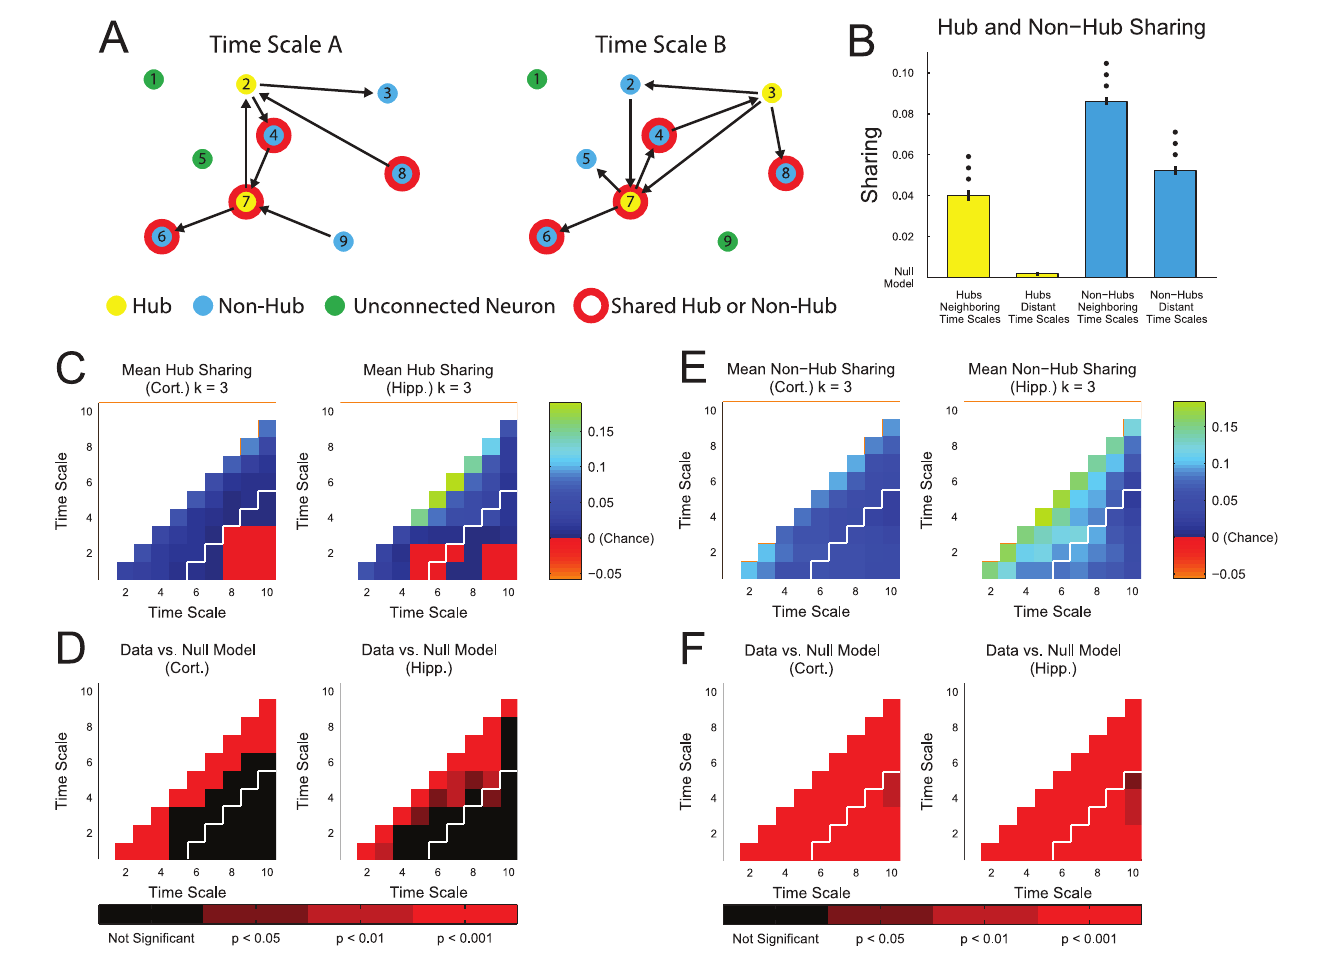
Fig. 5. Hub sharing was limited to adjacent time scales. ( A ) We classified each neuron as a hub, non-hub, or unconnected neuron at each time scale. A neuron was considered to be a shared hub or shared non-hub for two time scales if its status as a hub or non-hub was consistent across those time scales. Hubs were defined using a degree threshold set by the likelihood to have a given number of connections in a random network (0.05 in this illustrative diagram and 10 2 4 in the full analysis). ( B ) We calculated the amount of hub and non-hub sharing (see Materials and Methods ) for each pair of time scales and grouped the results into neighboring (4 or less) and distant (greater than 4) time scales. We found that hubs were only shared at a significant level for neighboring time scales, while non-hubs were broadly shared across all time scales (multiple comparisons correct Mann-Whitney Test (1, 2, and 3 dots: p , 0.05, 0.01, and 0.001 respectively), error bar: standard error of the mean). For each data set, we subtracted the mean sharing values for 500 trials with neuron identities randomized and neuron hub, non-hub, or unconnected status held constant. This null model approximates the amount of sharing expected based only on the number of hubs, non-hubs, and unconnected neurons in the data set, as well as the effect of ignoring the multiplex properties of the networks and considering the time scales to be truly independent networks. We also calculated the mean sharing value of ( C ) hubs and ( E ) non-hubs across each pair of time scales for cortical and hippocampal networks. In (B), neighboring time scale pairs are up and to the left of the white line, while distant time scale pairs are down and to the right of the white line. ( D and F ) Finally, we calculated the multiple comparisons corrected Mann-Whitney Test p-values between sharing results from data and sharing results from the null